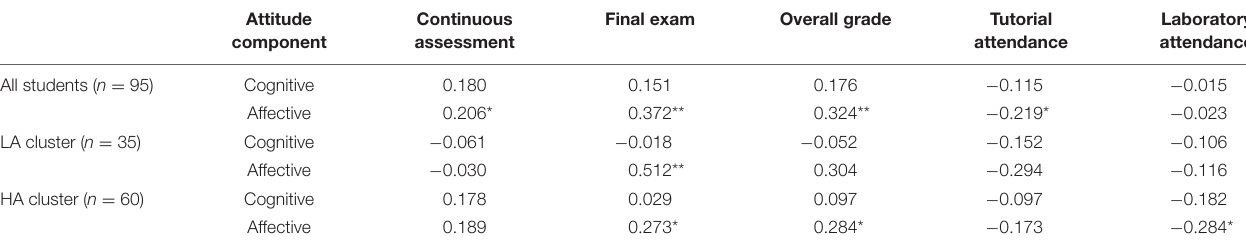
TABLE 3 | Correlation of attitude with attendance and achievement in the student